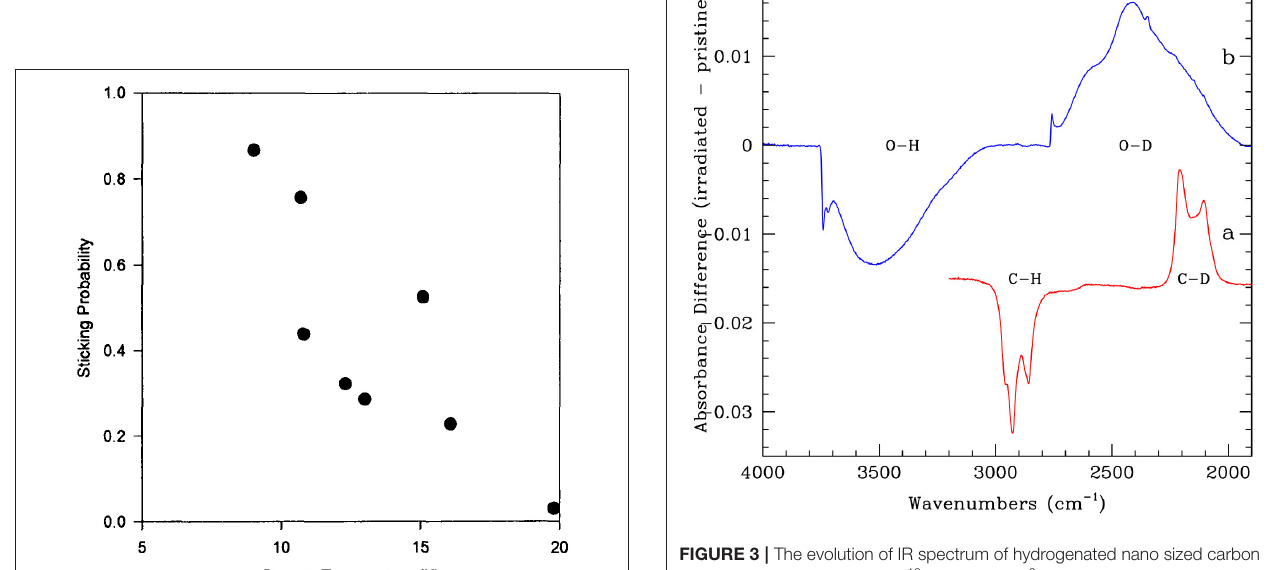
FIGURE 3 | The evolution of IR spectrum of hydrogenated nano sized carbon grains after irradiation of 1 × 10 19 D atoms cm − 2 (red curve a). The spectral evolution of Mg-rich hydroxylated amorphous silicate grains after irradiation of 3.8 × 10 18 D atoms cm − 2 is also reported (blue curve b). The spectra are shown after subtraction of the initial spectrum and are shifted in ordinate for the sake of